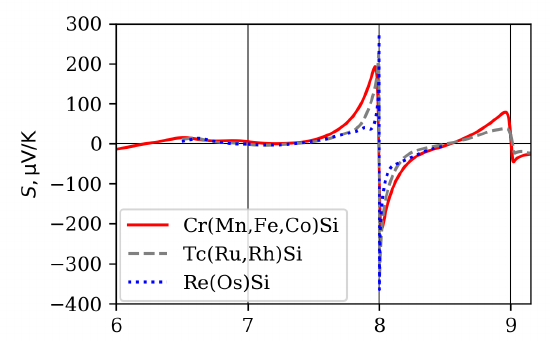
Figure 12. Room temperature Seebeck coefficients of considered transition-metal monosilicides of groups 6–9 of the Periodic Table, and of quasibinary alloys of intermediate